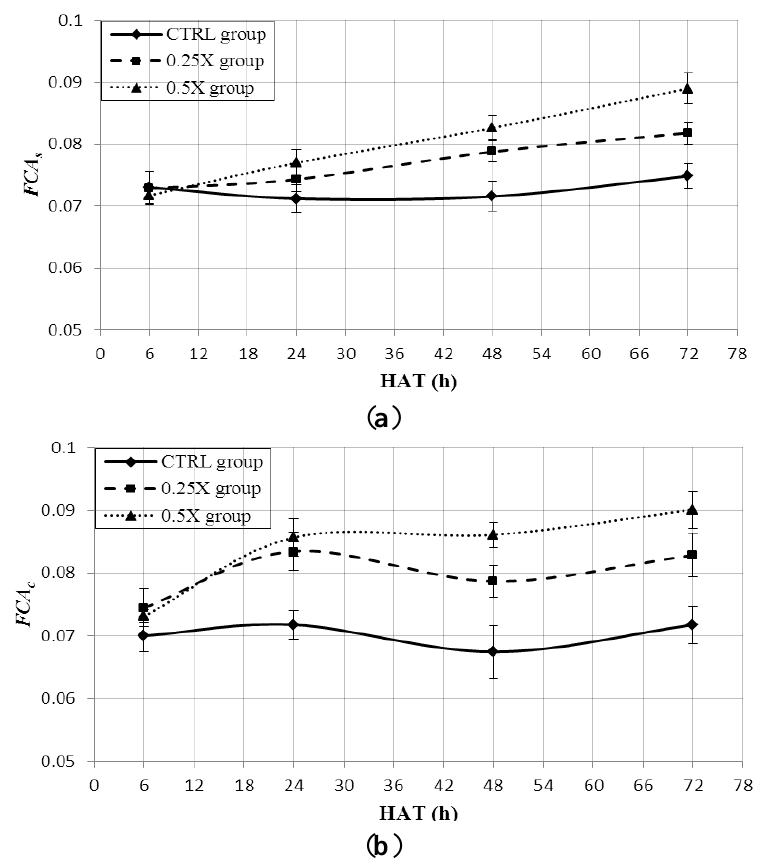
Figure 3. ( a ) FCA variation of soybean leaves of the three groups at 6, 24, 48, 72 HAT. s ( b ) FCA variation of cotton leaves of the three groups at 6, 24, 48, 72 HAT. Each point is c a mean value of six leaves for the same treatment. Error bar presents the standard deviation of each point.